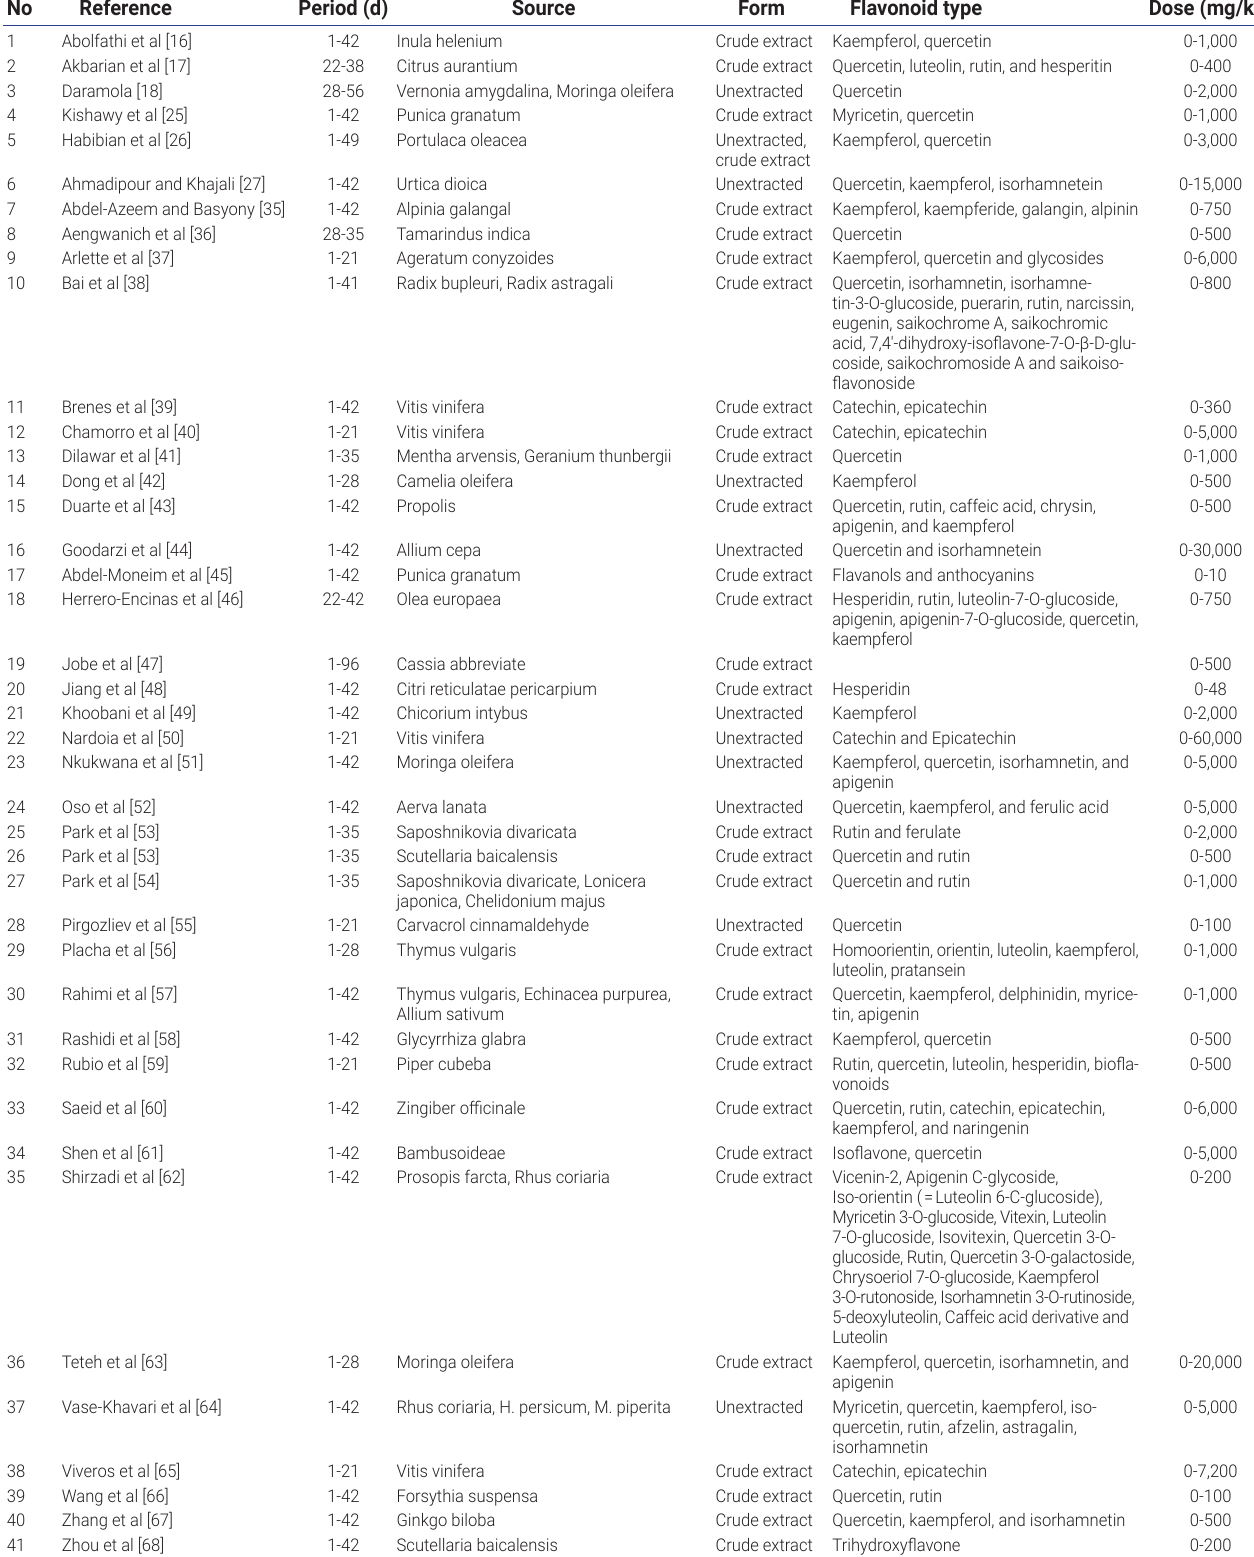
Table 1. Studies included in the meta-analysis of flavonoid addition on performance, carcass, blood composition and small intestinal morphology of